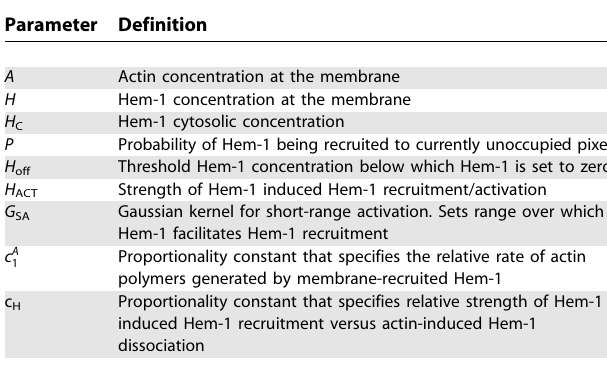
Table 1. Parameters for Mathematical Simulations of Hem-1